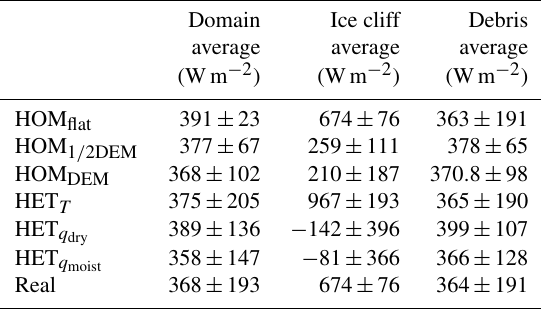
Table 2. The average conductive flux averaged over the domain, ice cliff cells and debris cells – with standard deviations. Ice cliffs cover 2% of the domain. The standard deviation is based on all pixel values in the